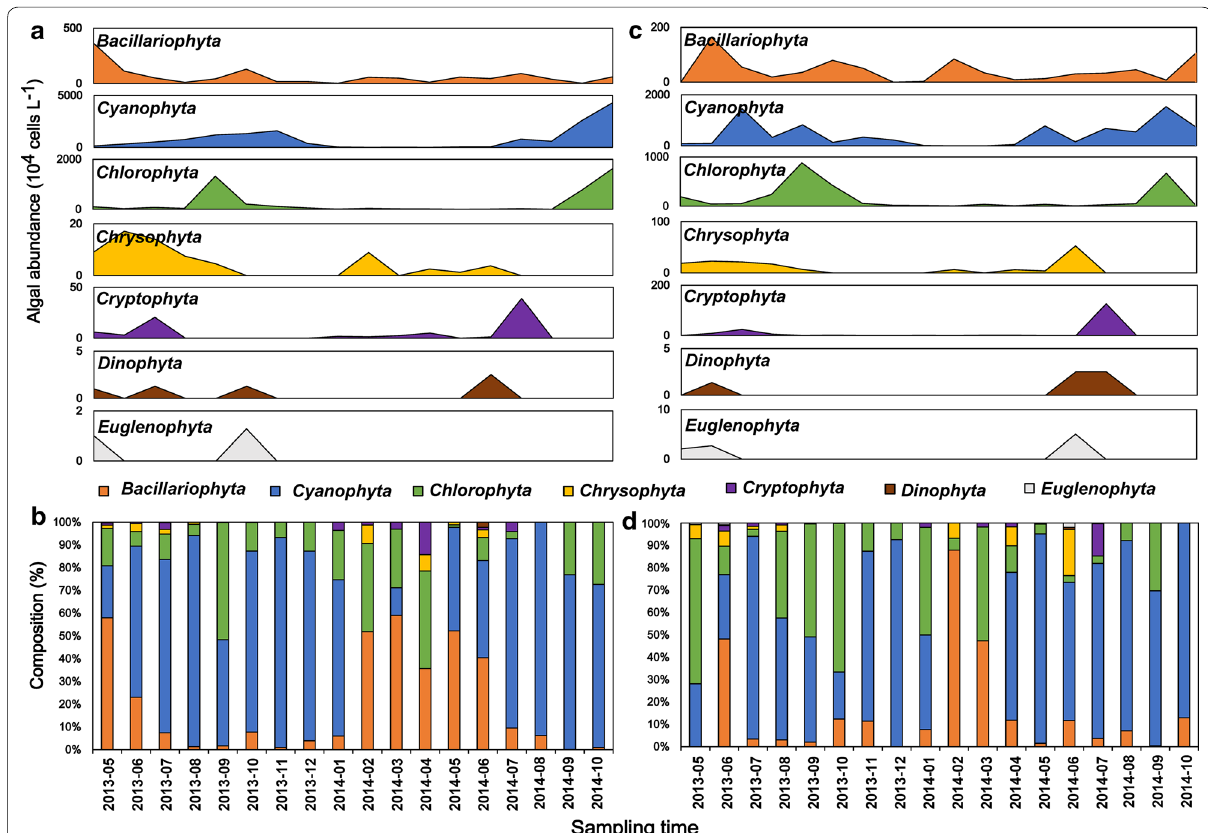
Fig. 2 Seasonal variations in the phytoplankton phyla in Lake Erhai from May 2013 to October 2014 at the two sampling sites ( a , b for site 1; c , d for site 2). a , c Densities of the phytoplankton phyla; b , d compositions of the phytoplankton phyla. Color codes represent the same phyla in each panel, and the Y-axis scales